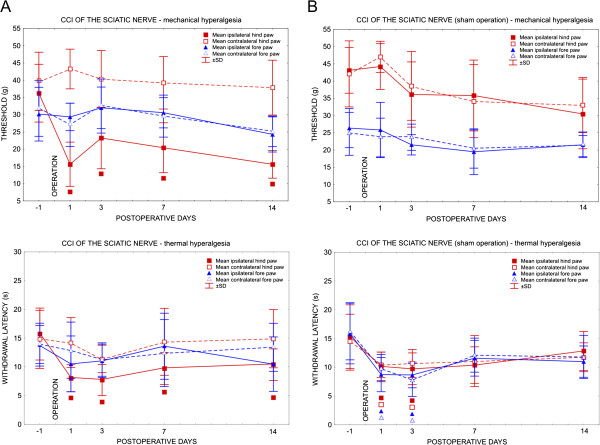
Results of behavioral test. (A) Results of behavioral tests in rats operated upon to create unilateral chronic constriction injury (CCI) of the sciatic nerve and (B) in sham-operated rats. Progressive development of evoked mechanical and thermal hyperalgesia was found in the ipsilateral hind paws of CCI rats. Transient thermal hyperalgesia was present bilaterally in both hind and fore paws 3 days after the sham operation. Data are expressed as mean ± SD of withdrawal thresholds (grams) and withdrawal latency (seconds) of mechanical and thermal hyperalgesia, respectively. Symbols identical to graph lines indicate significant differences (P<0.05) compared with measurements taken 1 day before operation.